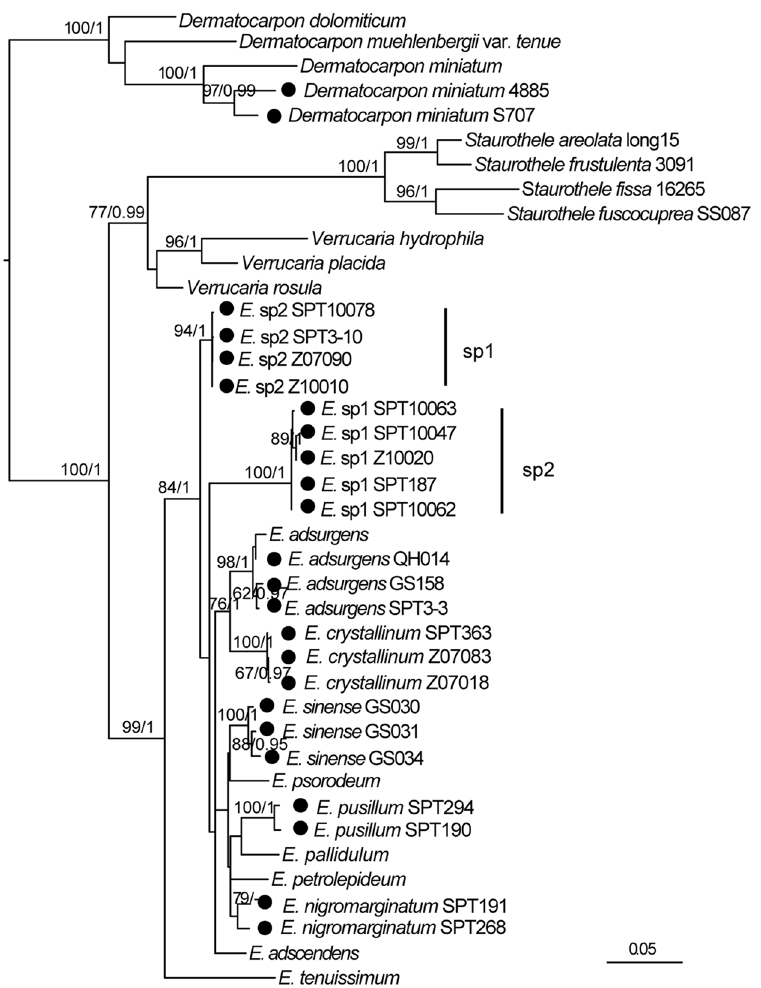
Figure 2. The maximum likelihood tree of Endocarpon species based on the concatenated ITS, ADK and UCEH sequences using the partition model. The numbers in each node represent bootstrap support (BS) and posterior probability (PP) values based on Bayesian analysis; numbers lower than 70 (BS) and 0.95 (PP) are not shown. Bootstrap values ≥ 75 and posterior probability values ≥ 95 were plotted on the branches of the RAxML tree. Newly generated sequences are marked with the symbol. combined with closely related sequences downloaded from GenBank. Scale = 0.05 substitution per